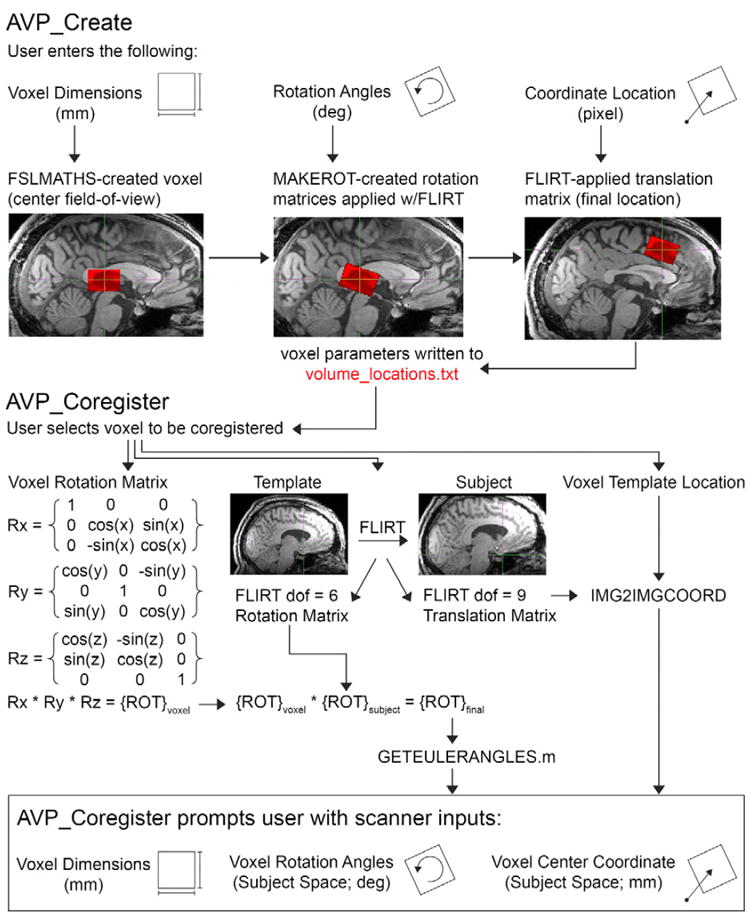
Upper panel: A schematic diagram of the ‘AVP_Create’
program is depicted. The user enters voxel dimension, rotation angles (about
each axis), and voxel center coordinate. ‘AVP_Create’ creates
the voxel in the center of the FOV. The voxel is rotated in the center of the
FOV and then translated to its final location. Lower panel: A
schematic diagram of the ‘AVP_Coregister’ program is depicted.
The user selects a template voxel for coregistration to the present research
subject. ‘AVP_Coregister’ will calculate the center voxel
location (‘FLIRT’ dof = 9 and
‘img2imgcoord’) and rotation angles (‘FLIRT’ dof
= 6) in subject space. ‘AVP_Coregister’ will prompt the
user with the scanner values (voxel dimensions, rotation angles, and voxel
center coordinate) needed to prescribe the voxel in subject space.